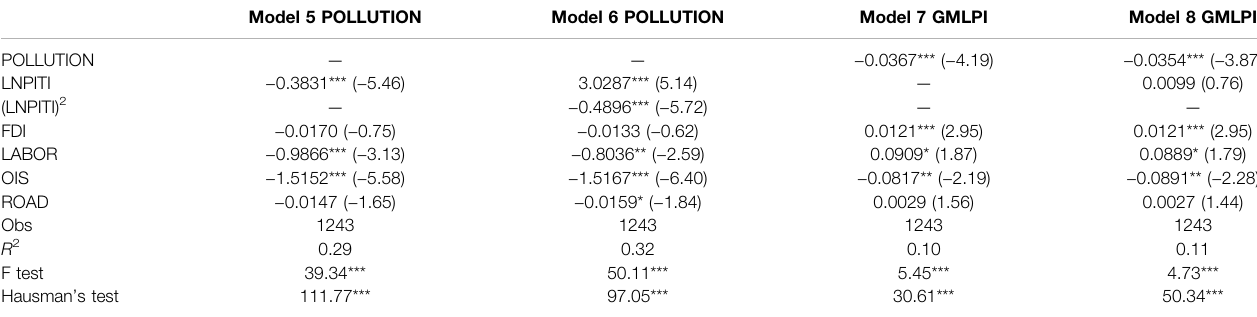
TABLE 4 | Regression results of the mediating effects model